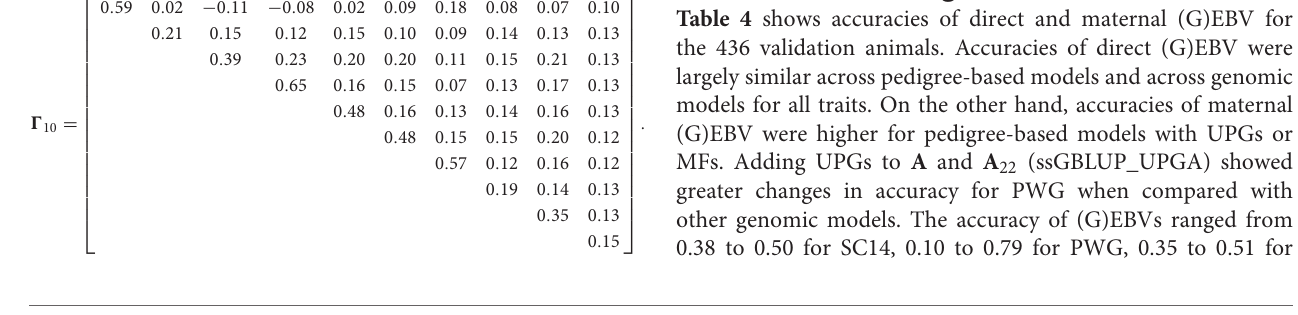
Accuracy 1 Correlation 2